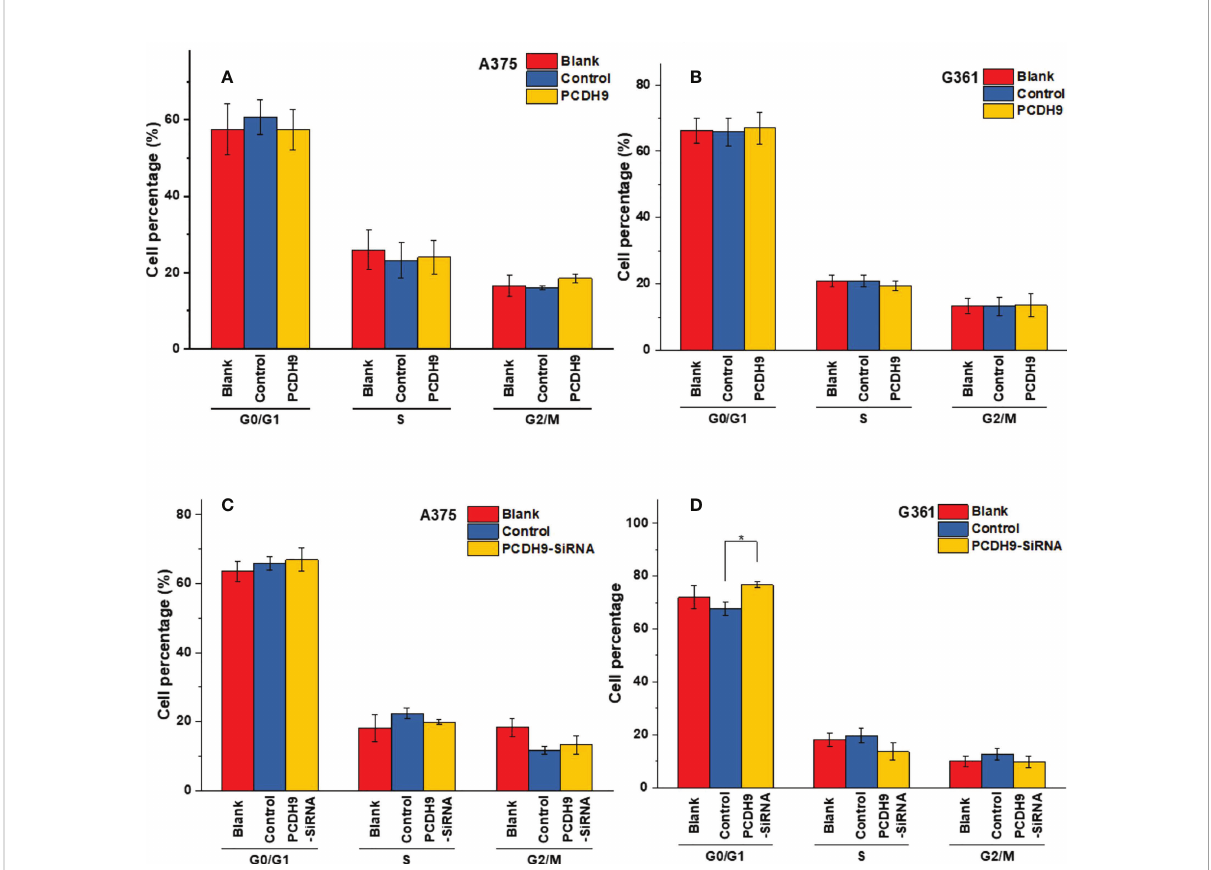
FIGURE 5 The varieties of PCDH9 expression did not signi fi cantly affect melanoma cell regulation. The cell percentage of melanoma cells affected by overexpressed PCDH9 in different cell period time in A375 (A) and G361 (B) cell lines. The cell percentage of melanoma cells affected by PCDH9 interference in different cell period time in A375 (C) and G361 (D) cell lines. * p < 0.05 compared in groups by using one-way ANOVA followed by least signi fi cant difference post hoc